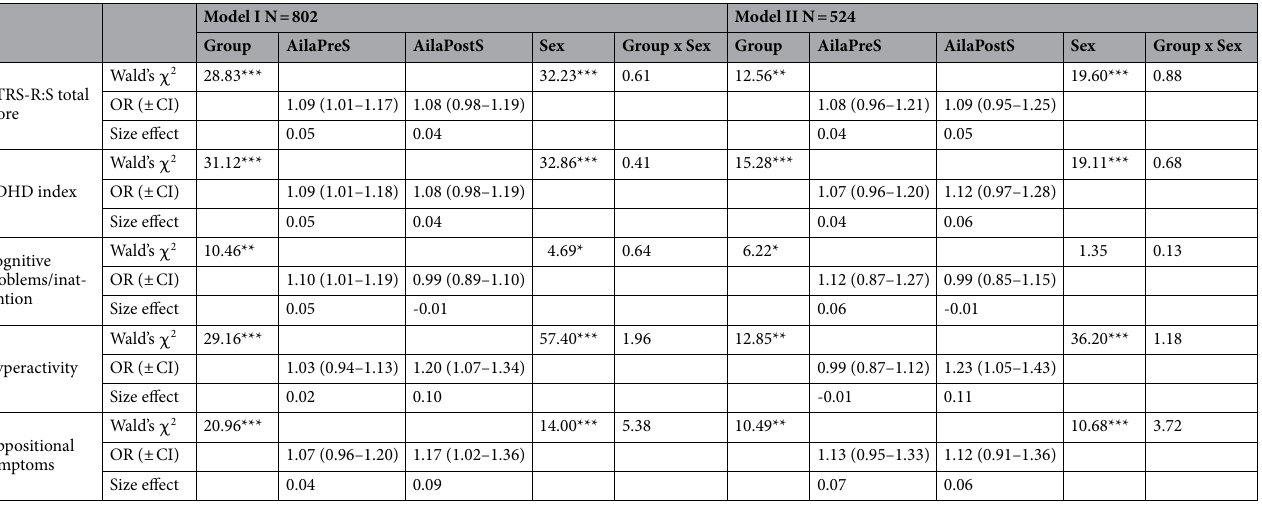
Table 3. Results of the Generalised Linear Model (GLM), where CTRS-R:S indices were dependent variables, and groups (AilaPreS, AilaPostS, Control group) and sex were independent variables. Model I included only age as a covariate, whereas Model II included several confounders: age, parental education, family income, mother’s HRSS score, gestational age and birth weight. AilaPreS prenatally Aila-exposed children, AilaPostS postnatally Aila-exposed children, Control non-exposed to Aila counterparts, OR odds ratio, ± CI 95% confidence interval for odds ratio. ***p < 0.001, **p < 0.01, *p <